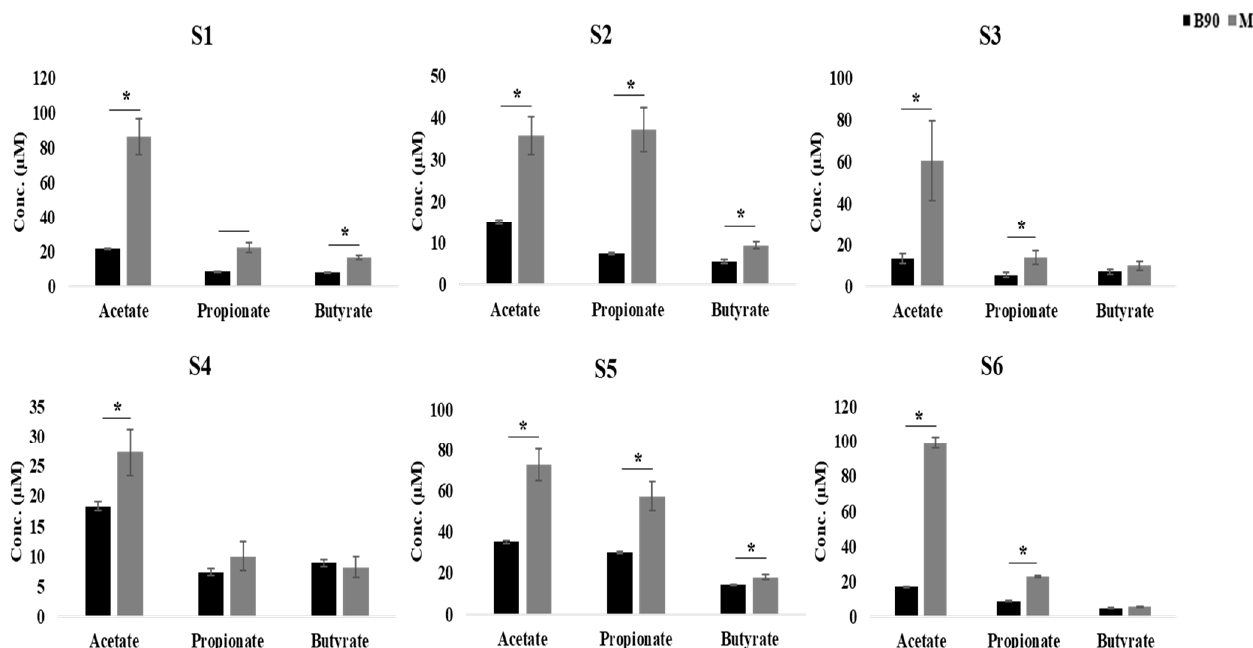
Figure 2. Quantitative comparison of SCFA production in each subject with and without digested beef treatment, as represented by grey and black bars, respectively (*; p < 0.05).